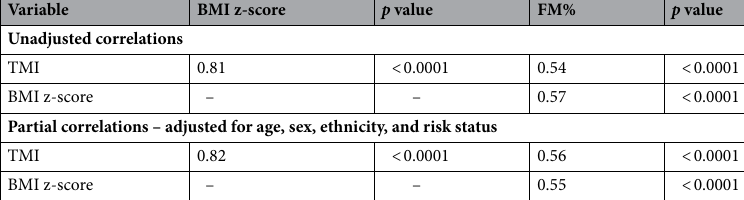
Table 4. Partial correlations of TMI and BMI z-scores with DEXA-based Fat Mass Percentage (adjusted for age, sex, ethnicity and risk status). TMI triponderal mass index, BMI body mass index, FM % fat mass